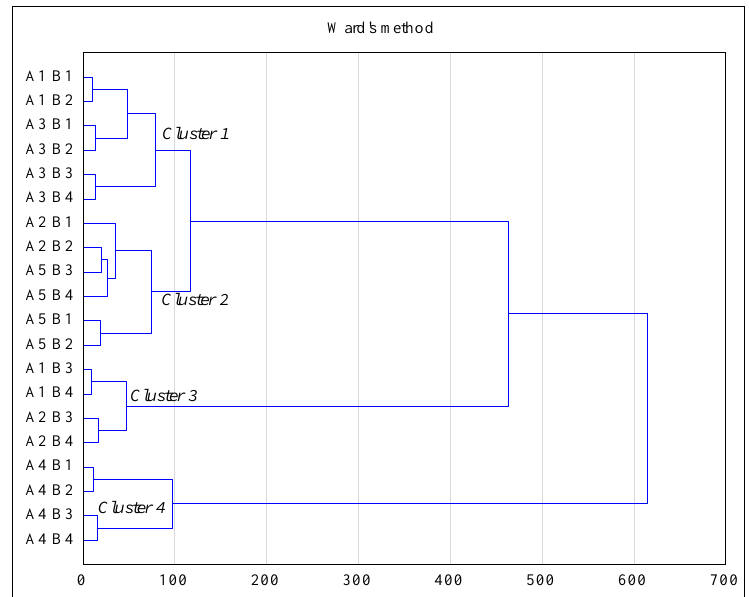
Figure 2. Dendrogram of tillage methods: A1 — post-harvest: grubber with a roll; pre-sowing: grubber + seeder-cultivator unit, A2 — post-harvest: grubber with a roll; sow ploughing + seeder- grubber + seeder-cultivator unit, A2—post-harvest: grubber with a roll; sow ploughing + seeder- cultivator unit, A3 — single ploughing + seeder-cultivator unit, A4 — post-harvest: manure + grubber cultivator unit, A3—single ploughing + seeder-cultivator unit, A4—post-harvest: manure + grubber with a roll; pre-sowing: sow ploughing + seeder-cultivator unit, A5 — direct sowing, and stubble with a roll; pre-sowing: sow ploughing + seeder-cultivator unit, A5—direct sowing, and stubble managements: B1 — leaving the shredded straw, B2 — leaving the shredded straw + EM, B3 — managements: B1—leaving the shredded straw, B2—leaving the shredded straw + EM, B3—removing removing the straw + EM in the stubble, B4 — moving the straw. the straw + EM in the stubble, B4—moving the